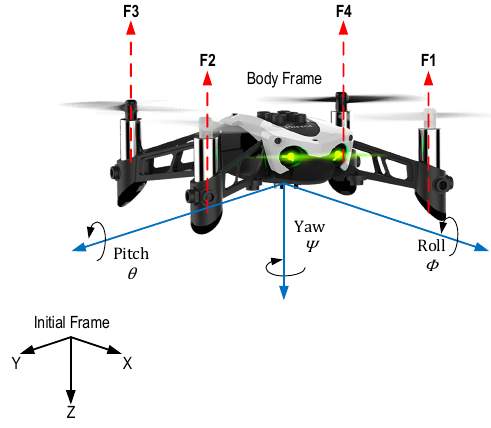
Figure 1. Parrot Mambo minidrone